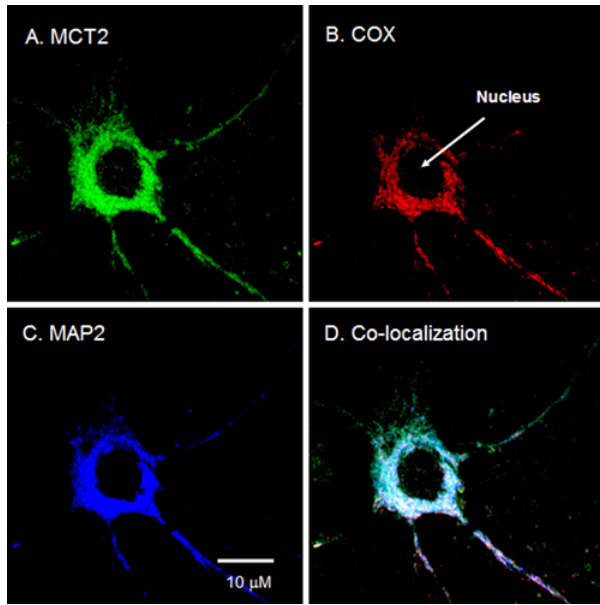
Figure 8. Immunohistochemical images demonstrating mito- chondrial MCT2 in a cultured neuron from rat hippocampus. Superposition of signals from probes for MCT2 (A, green), COX (B, red), and MAP2 (C, blue) showed extensive colocalization (D, white) in a cultured neuron. Scale bar=10 m m.